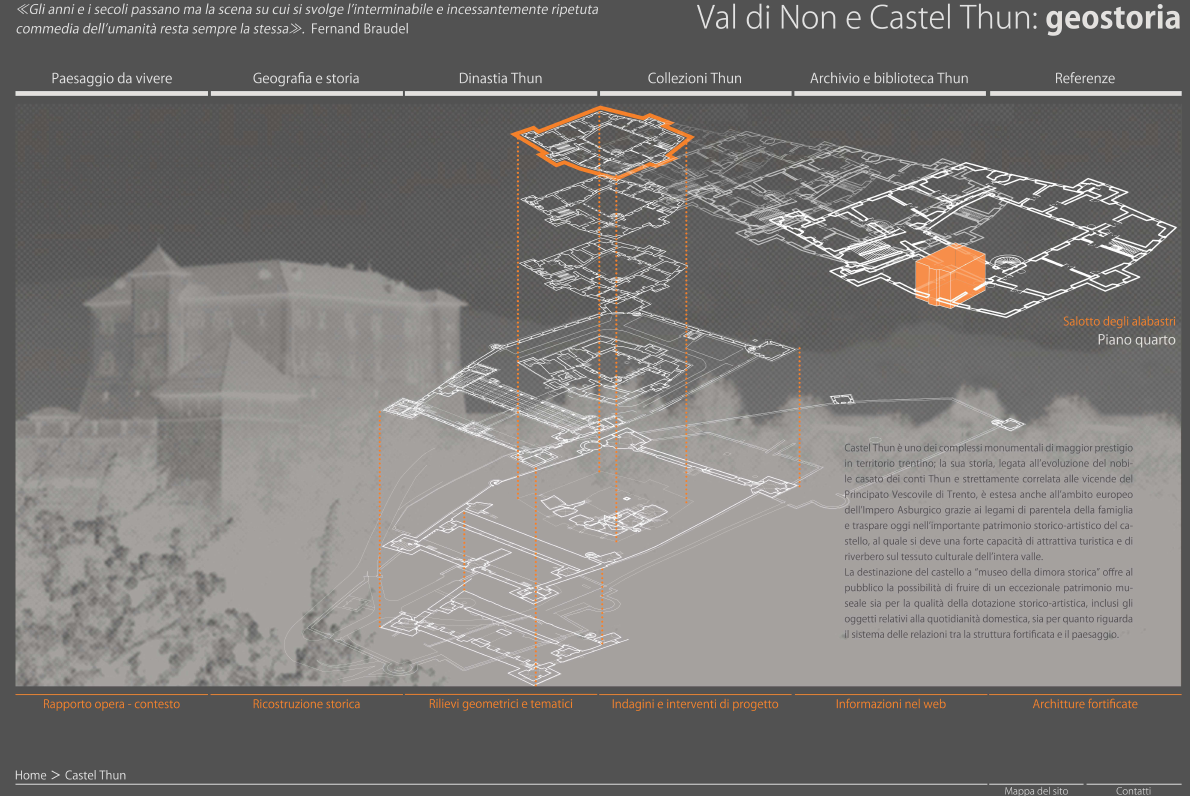
Figure 7. Consultation screen of information about Thun